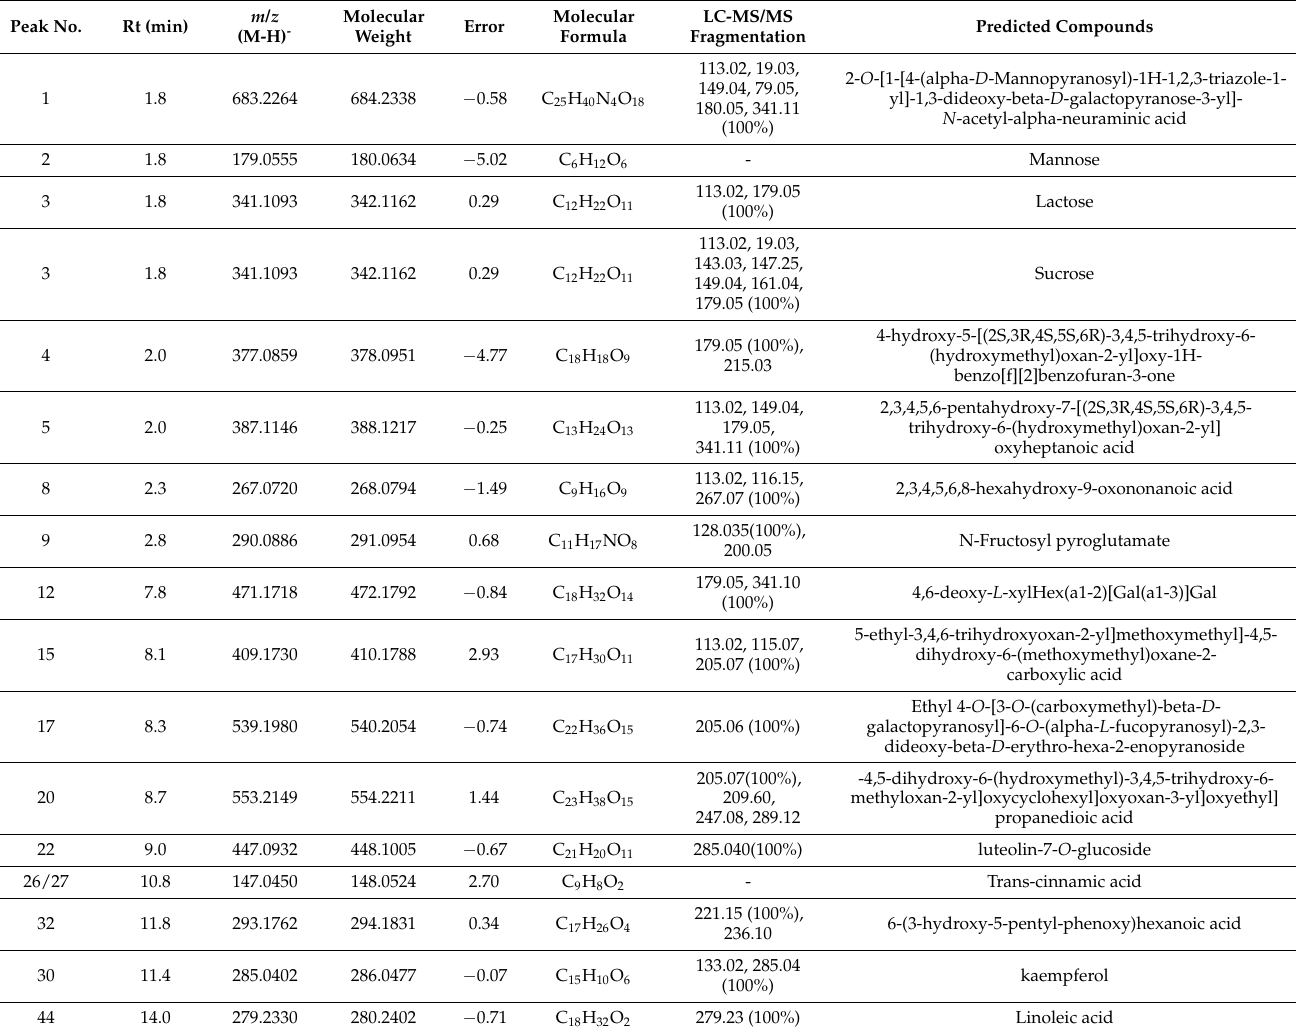
Table 3. Liquid chromatography–tandem mass spectrometry (LC–MS/MS) of ethanol extract Cassia grandis